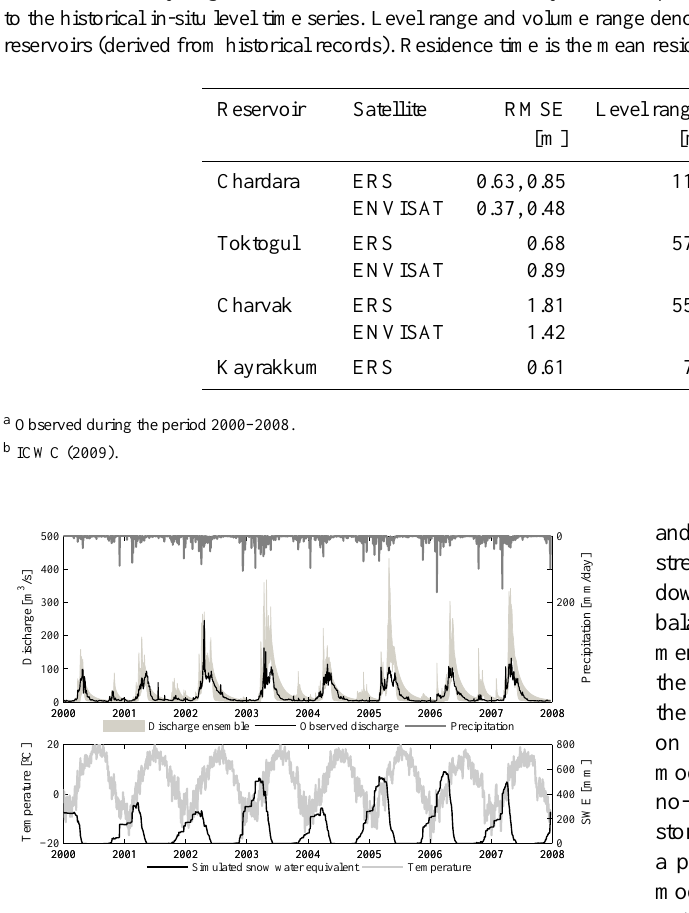
Fig. 6. Rainfall-runoff modeling results in catchment